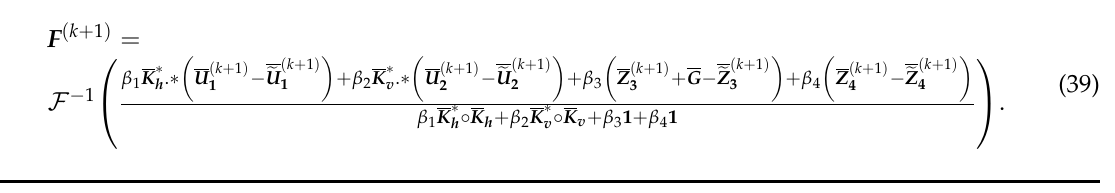
Algorithm 1 OGS-Lp-FAST